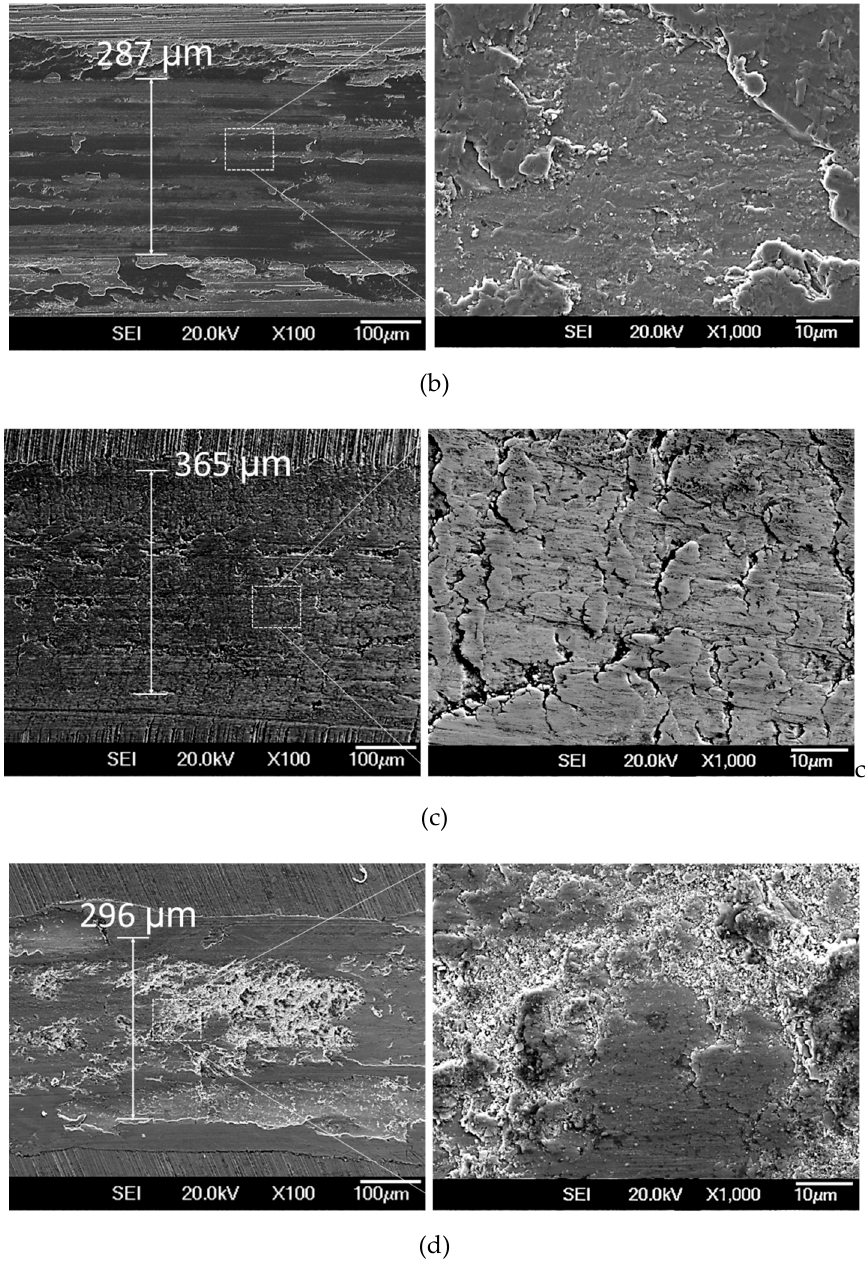
Figure 9. SEM images showing morphology of the wear scars: ( a ) HT-D2, ( b ) M4, ( c ) HWS, and ( d ) HT-HWS.